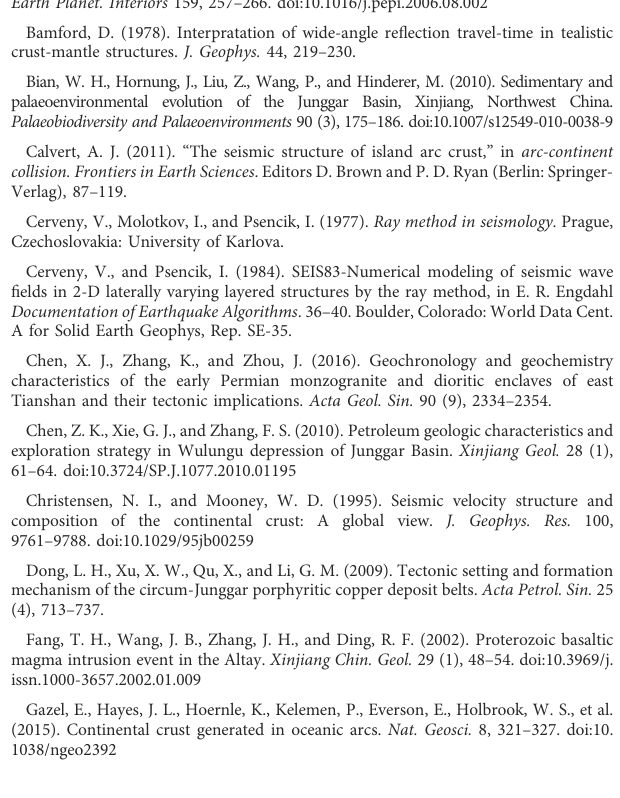
SUPPLEMENTARY FIGURE S1 Shot gathers S03-S06, the diagrams also displayed the vertical component of seismic records, which were also reduced with the velocity 6.0 km/s. SUPPLEMENTARY FIGURE S2 Shot gathersS07-S10, thediagrams also displayed thevertical componentof seismic records, which were also reduced with the velocity 6.0 km/s. SUPPLEMENTARY FIGURE S3 Ray coverage of the DSS pro fi le for all shots. SUPPLEMENTARY FIGURE S4 Computed synthetic seismograms based on the fi nal velocity model for all